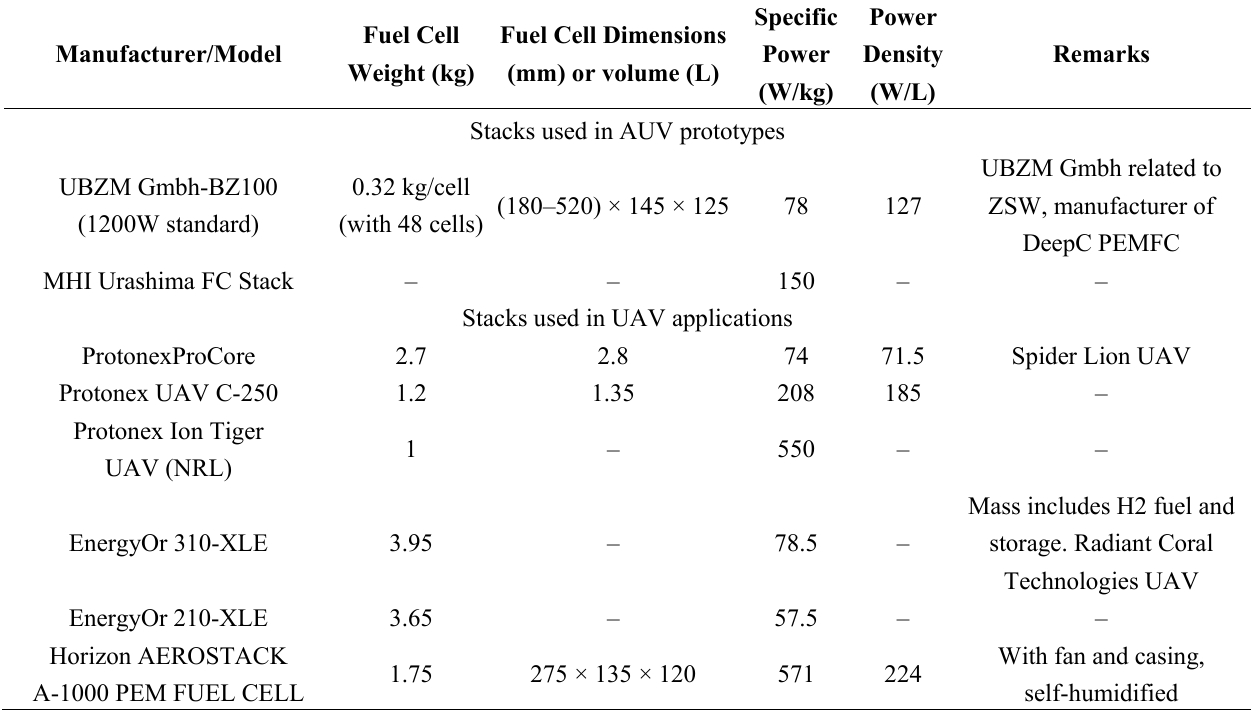
Table 2. Fuel cell stack specifications (based on